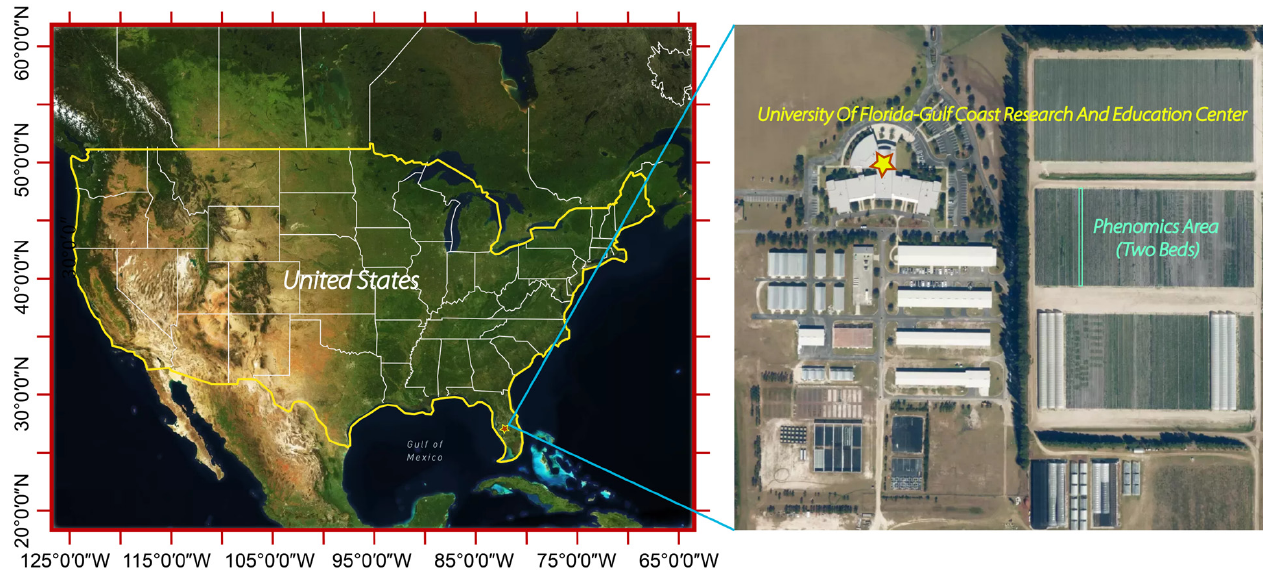
Figure 1. Study site of the strawberry field at Gulf Coast Research and Education Center of University of Florida. Table 1. Statistics of dry biomass of 17 genotypes measured throughout the 2020–2021 growing season using destructive methods.